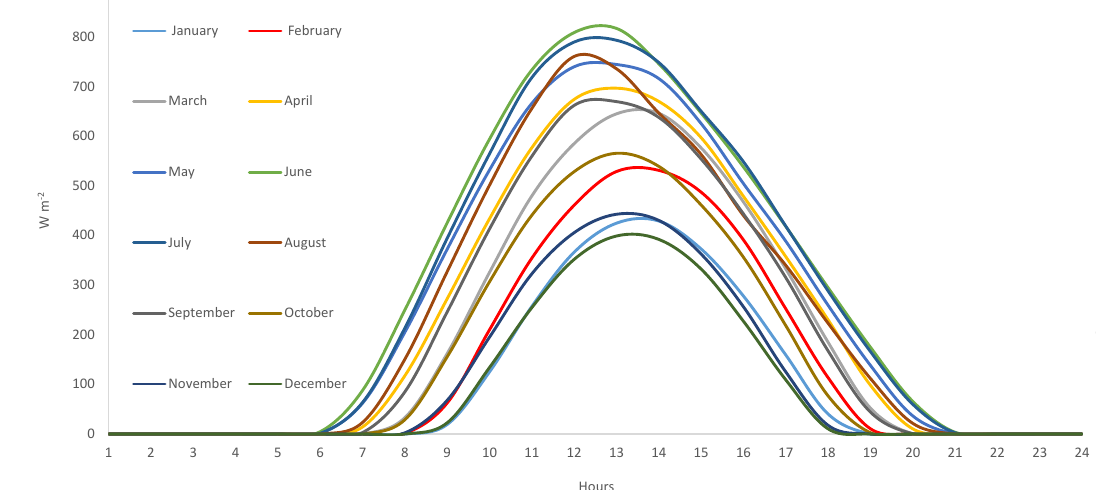
Figure 1. Double periodicity diagram of Solar radiation (i.e. averaged measured value for each hour) for Denver station.